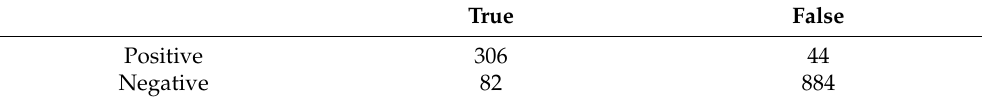
Table 6. Confusion matrix of SVM classifier applied ten days before the swarming event. True False Positive